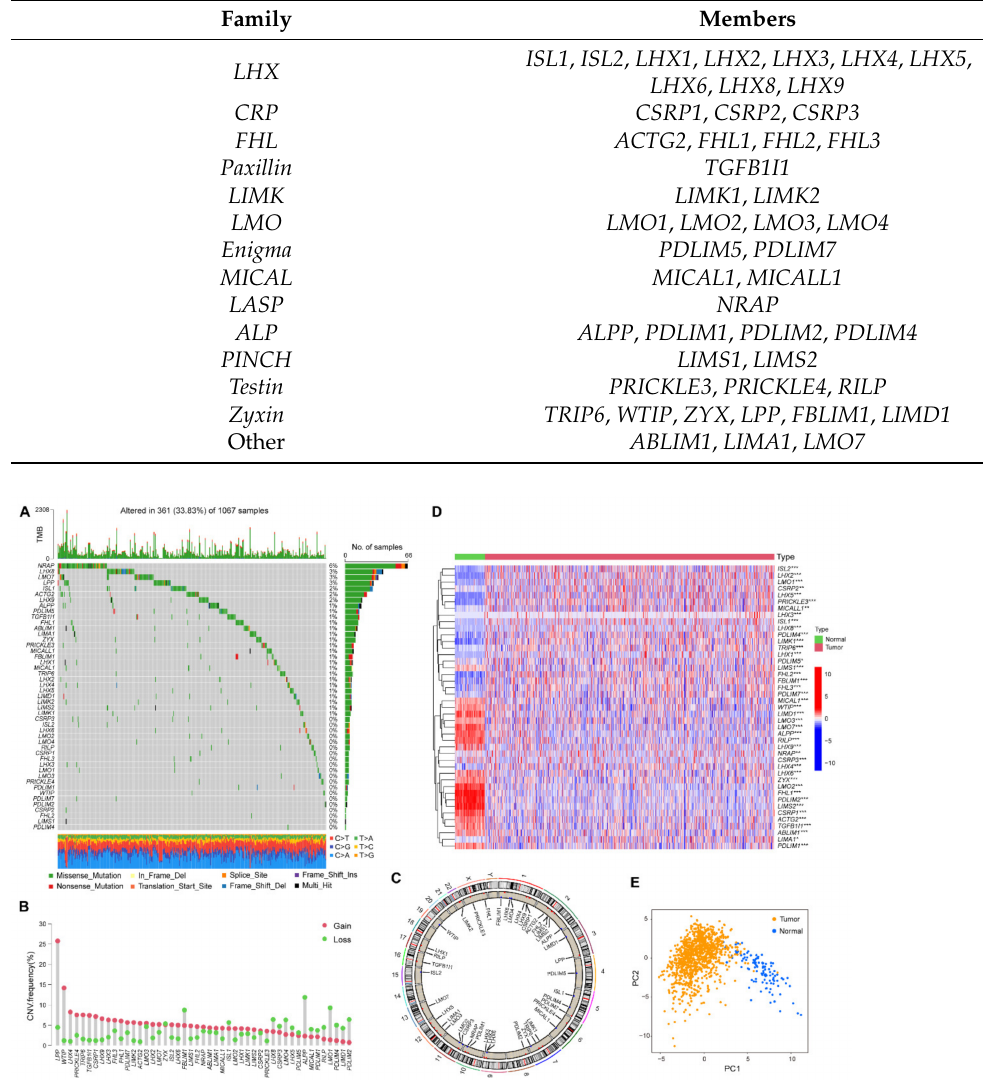
Figure 1. The genetic landscape of the LIM domain family genes in non-small-cell lung cancer (NSCLC). ( A ) Mutation frequencies of 47 LIM domain family genes in 1067 patients with NSCLC in The Cancer Genome Atlas. Each column indicates one patient. The top bar indicates tumor mutation burden. The numbers on the right represent the mutation frequency in each gene. The right bar indicates the proportion of each variant type. The stacked bar indicates the fraction of conversions in each sample. ( B ) The CNV alternations of 47 LIM domain family genes in NSCLC. The red dot indicates amplifications, and the green dot represents deletions. The height of the column suggests the alteration frequency. ( C ) The location of CNV alterations of LIM domain family genes. ( D ) The heatmap of differentially expressed LIM domain family genes between NSCLC and normal tissues. Low expression, blue; high expression, red. * p < 0.05; ** p < 0.01; *** p < 0.001. ( E ) Principal component analysis for 43 differentially expressed LIM domain family genes to distinguish samples in NSCLC and normal